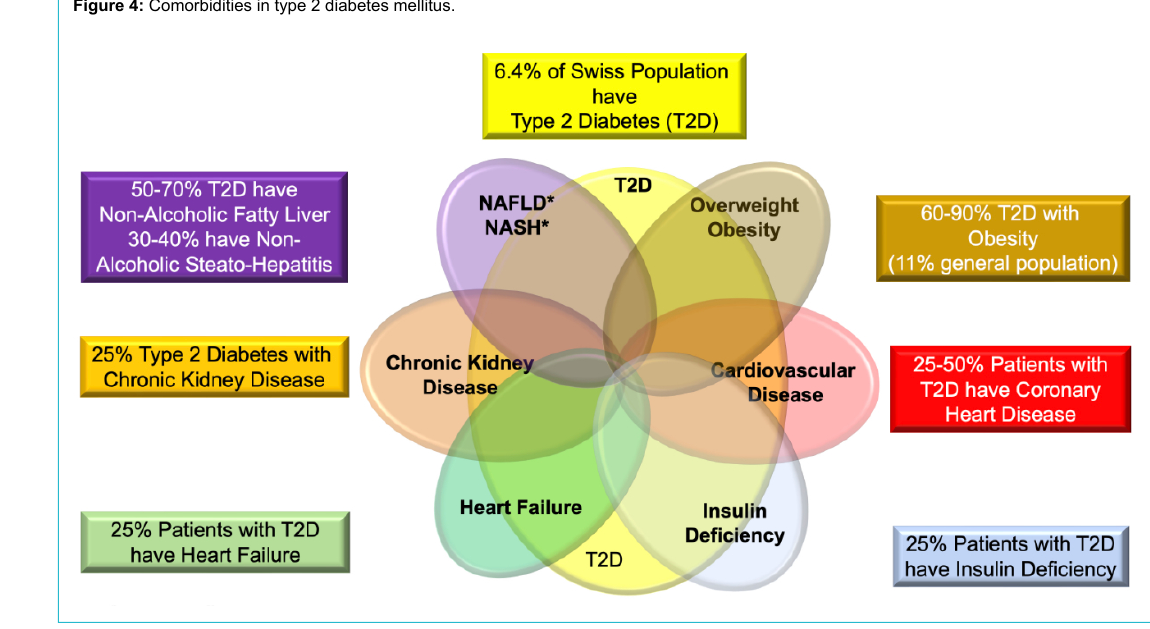
Figure 4: Comorbidities in type 2 diabetes